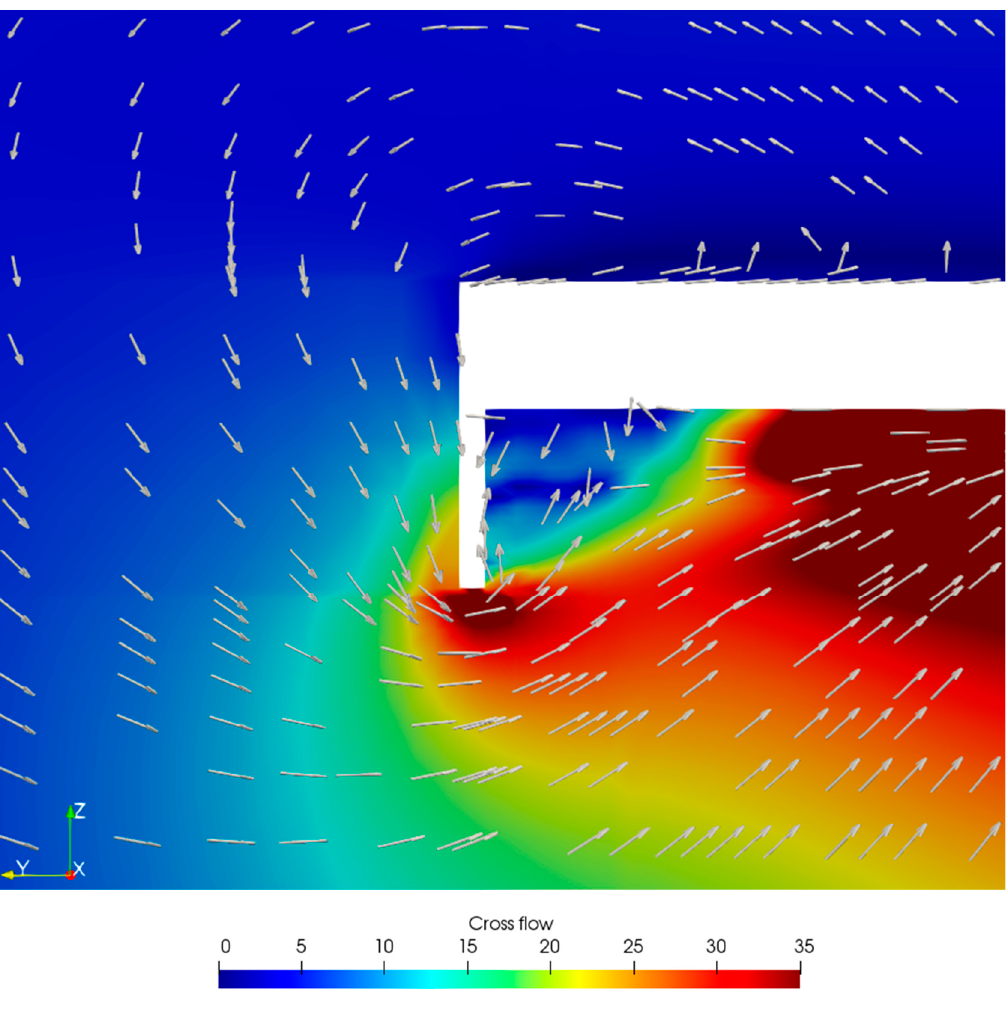
Figure 13. Cross flow at x = 0.7 m ( F r = 0.173, C q = 0.149). The drag reduction of the flat plate was predicted using the CLSVOF and VOF solv- ers. Figure 14 shows the total drag reduction rate ( 𝜂 (cid:3021) ) for various injected airflow rates